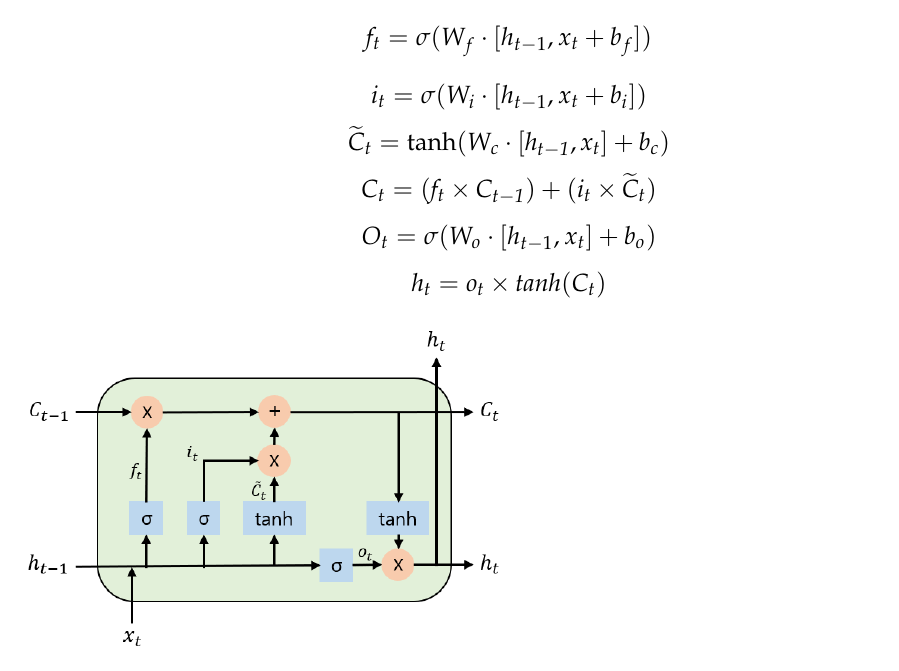
Figure 7. Structure of the LSTM cell.